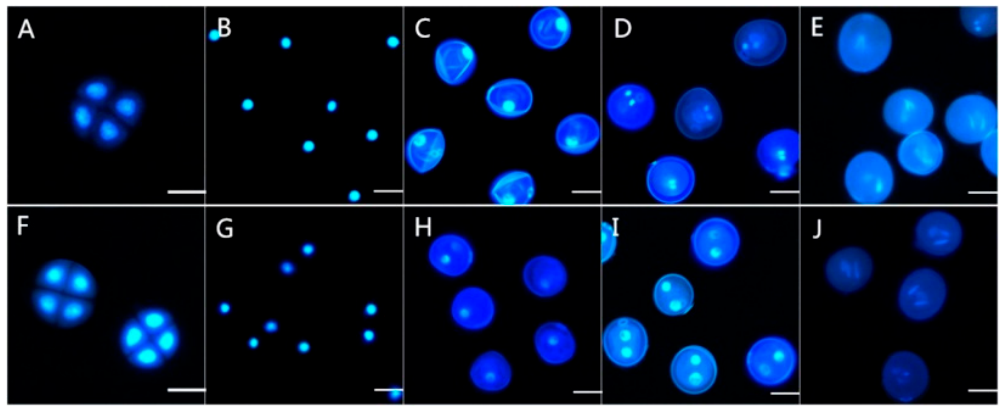
Figure 2. DAPI stained pollen from KTM3315A ( A – E ) and its maintainer line TM3315B ( F – J ). ( A , F ) Tetrad stage; ( B , G ) early uninucleate stage; ( C , H ) later uninucleate stage; ( D , I ) binucleate stage; and ( E , J ) trinucleate stage. Bar: 50 μ m.